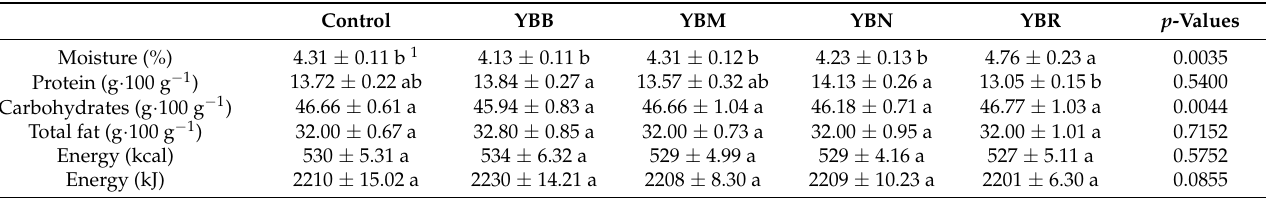
Table 4. Proximate composition of yogurt bites.